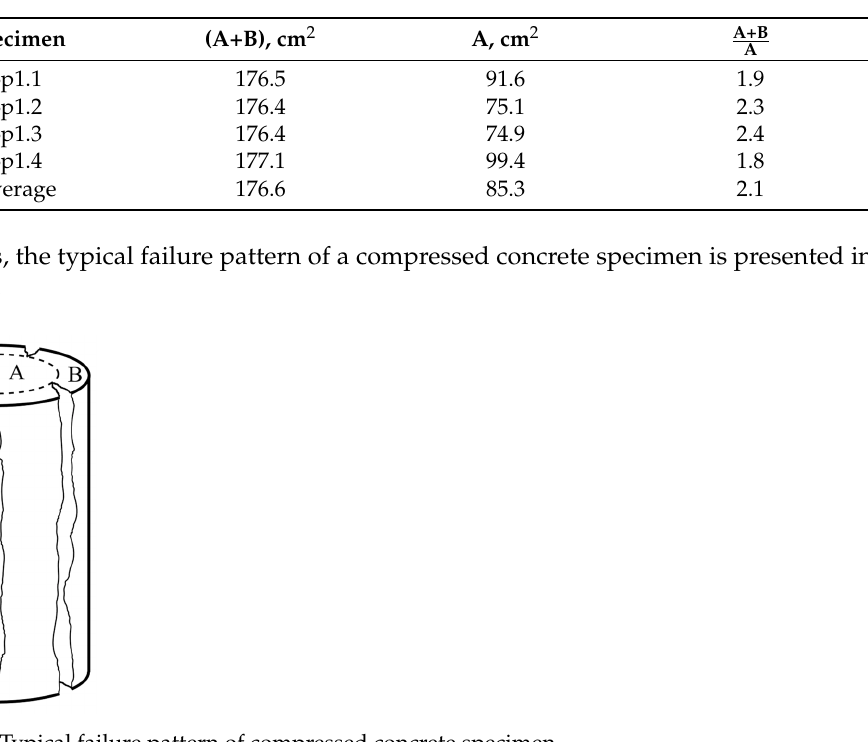
Figure 12. Typical failure pattern of compressed concrete specimen.